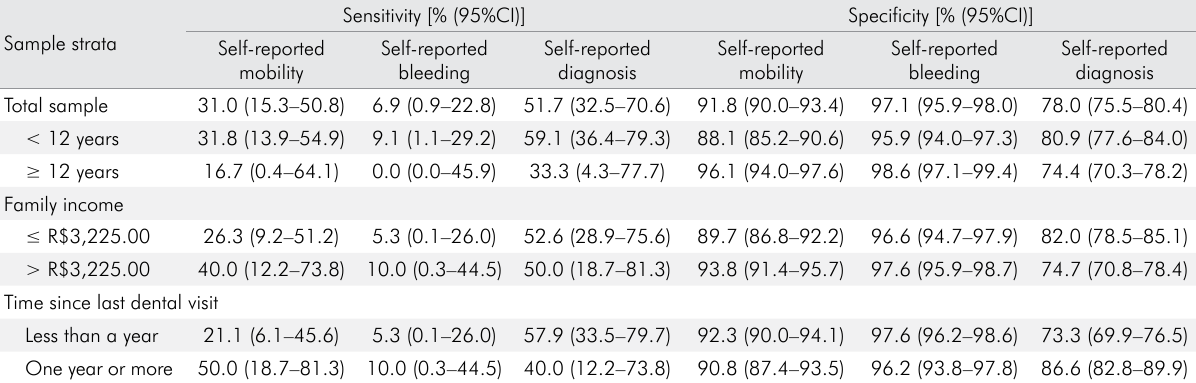
Table 3. Sensitivity, specificity and 95%CI for the first clinical definition of periodontitis (≥ 6.0 mm periodontal pocket and clinical attachment loss of 4.0 mm or more in the same tooth, in one or more